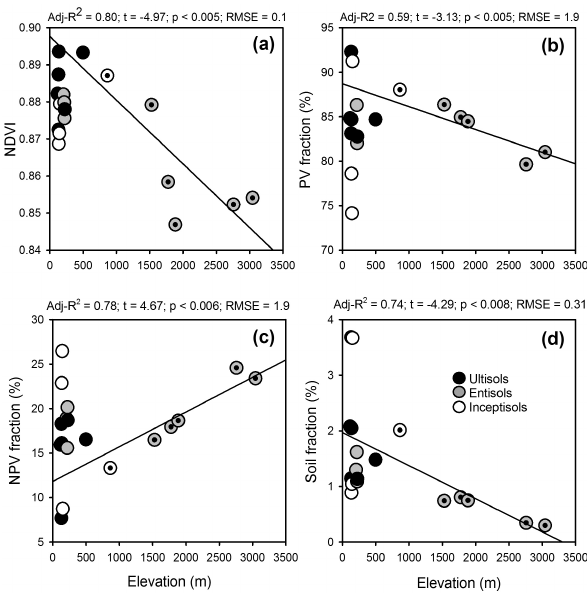
Fig. 9. Elevation-based changes in (a) NDVI, (b) PV fraction, (c) NPV fraction, and (d) soil fraction derived from imaging spec- troscopy. Data are means for each 25ha landscape. Symbols are colored by USDA soil order; and dots within circles indicate sites included in elevation-based regression of main